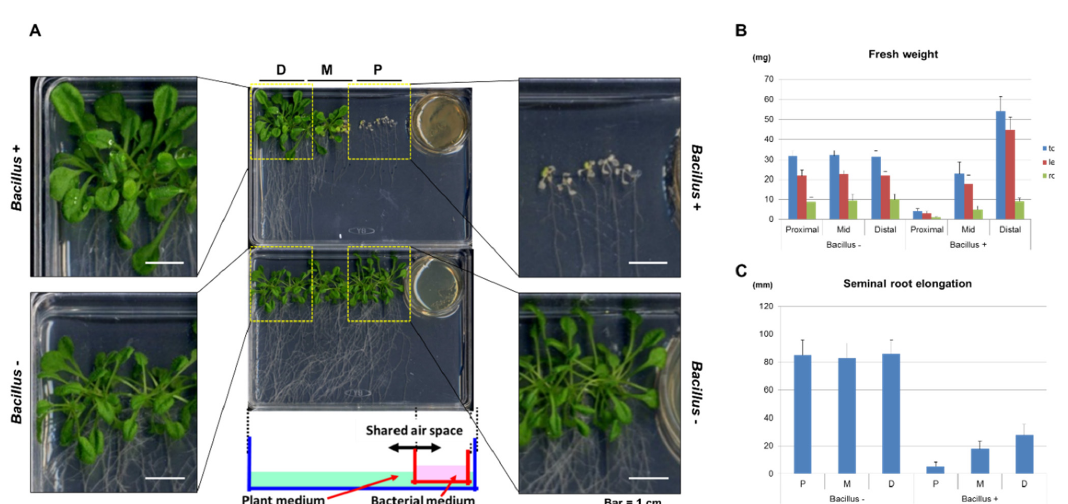
Figure A1. Bacillus VOCs affect the growth of Arabidopsis seedlings in a distant-dependent manner. ( A ) Magnified view of Arabidopsis seedlings that were subjected to the co-culture with Bacillus culture as shown in Figure 1. ( B ) Mean fresh weight ( ± SD) of the Arabidopsis seedlings with or without exposure to Bacillus VOCs for 5 days in the bioassay as shown in Figure 1A. Five seedlings each (fifteen seedlings in total) were transplanted to the proximal (P), mid (M) and distal (D) positions. Note that the fresh weight of the Arabidopsis seedlings was severely decreased in the P position, whereas seedlings in the D position exhibited increased biomass. (n = 5) ( C ). The mean length of seminal root elongation of Arabidopsis seedlings upon exposure to Bacillus VOCs. (n = 5).